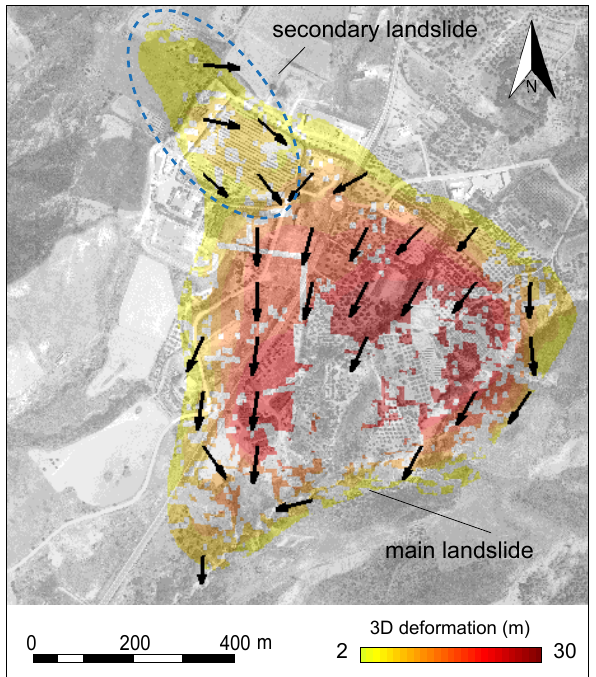
Figure 3. The new Montescaglioso landslide of 3 December 2013. Map of the surface deformation obtained through the pixel-offset (PO) analysis prepared using the © 3DA approach (Allasia et al., 2013). Colours show magnitude of the 3-D deformation field. Ar- rows show direction of movement (unit vectors) derived from the PO analysis in the E–W and N–S plane. Deformations smaller than 2m are not shown. The deformation field shows two main direc- tions of motion: (i) a dominant SSW direction caused by the main landslide and (ii) a secondary SSE direction caused by a parasitic landslide, encompassed by the dashed blue